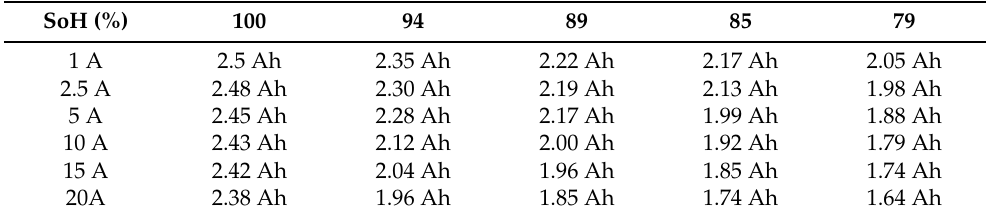
Table 1. Battery cell capacity at different discharge current and different SoH. SoH (%) 100 94